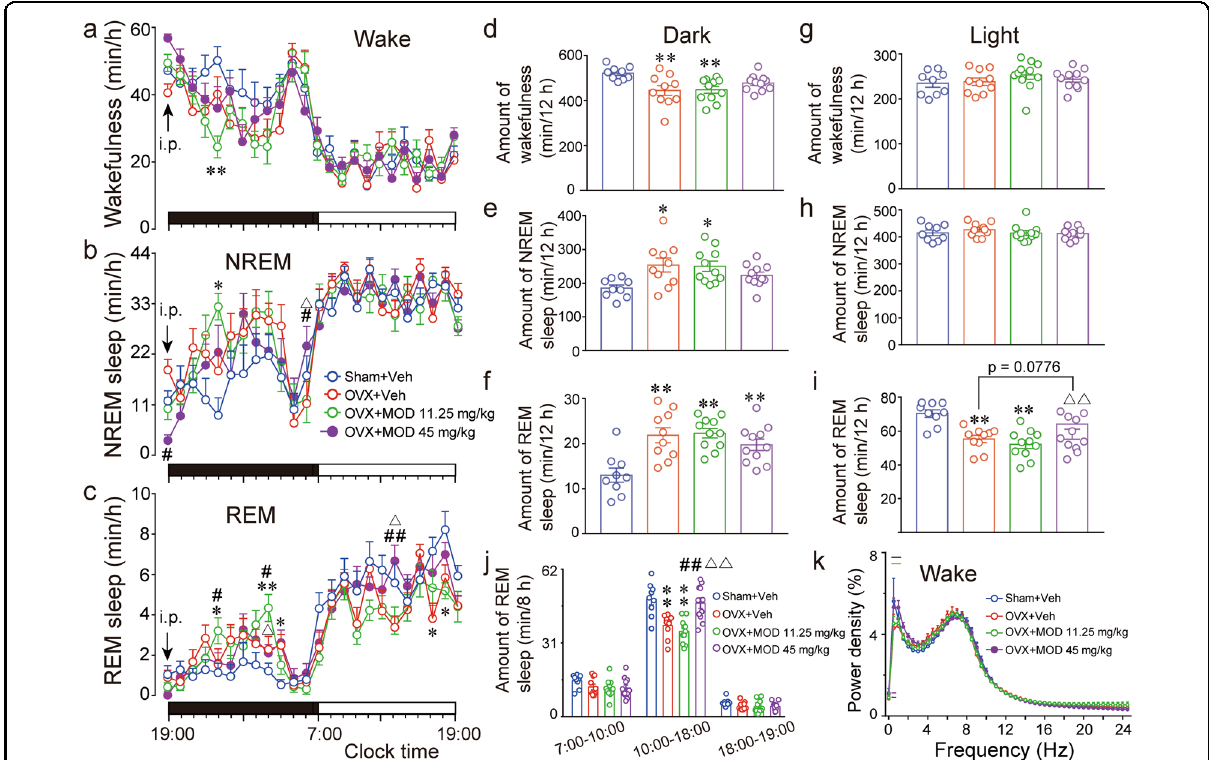
Fig. 6 Moda fi nil ameliorates ovariectomy-induced decreases in daytime REM sleep and impairments of delta electroencephalogram power of wakefulness during the active phase. a – c Time courses of average hourly wakefulness ( a ), NREM sleep ( b ), and REM sleep ( c ) during the 24 h after 8 days of moda fi nil (MOD) or vehicle (Veh) intraperitoneal injections in mice with the protocol for sleep recording shown in Fig. 3a. The horizontal fi lled and open bars on the x -axes indicate the 12-h active and inactive phase, respectively. d – i The total amount of wakefulness ( d , g ), NREM sleep ( e , h ), and REM sleep ( f , i ) during the 12-h active (19:00 – 07:00) ( d – f ) and 12-h inactive (7:00 – 19:00) ( g – i ) phase, respectively, after seven days of MOD treatment. j In the inactive phase, amount of REM sleep during the 3-h (7:00 – 10:00), 8-h (10:00 – 18:00), and 1-h (18:00 – 19:00) periods. * p < 0.05, ** p < 0.01 versus Sham + Veh; # p < 0.05, ## p < 0.01 versus OVX + Veh group; △ p < 0.05, △△ p < 0.01 compared with OVX + MOD 11.25mg/kg group. Sham + Veh: n = 9; OVX + Veh: n = 10; OVX + MOD 11.25 mg/kg, OVX + MOD 45 mg/kg: n = 11 per group. k The average electroencephalogram power density of wakefulness during the 12-h active phase in different groups of mice after eight consecutive days of MOD treatment. The horizontal bars indicate statistical differences ( p < 0.05) between groups assessed by Tukey comparisons. Under the curves: blue bars for OVX + Veh group versus Sham + Veh; purple bars for OVX + MOD 11.25mg/kg versus Sham + Veh. Above the curves: yellow bars for OVX + MOD 45 mg/kg versus OVX + Veh group; black bars for OVX + MOD 45 mg/kg versus OVX + MOD 11.25 mg/kg group. Sham + Veh: n = 9; OVX + Veh, OVX + MOD 11.25 mg/kg, OVX + MOD 45 mg/kg: n = 10 per